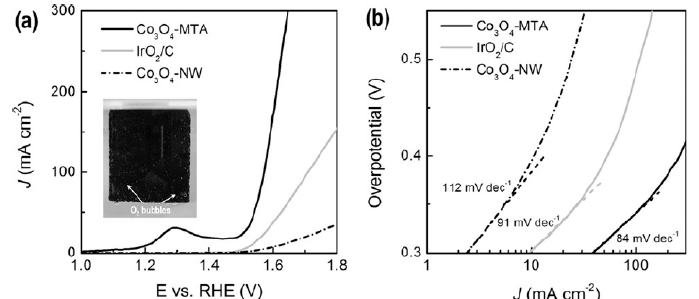
Figure 16. Electrochemical characterization of Co 3 O 4 ‐ MTA: ( a ) Linear sweep voltammograms and ( b ) Tafel slopes, compared to IrO 2 /C and Co 3 O 4 ‐ NW, respectively. Reproduced from [48], with permission from John Wiley and Sons, copyright 2017.